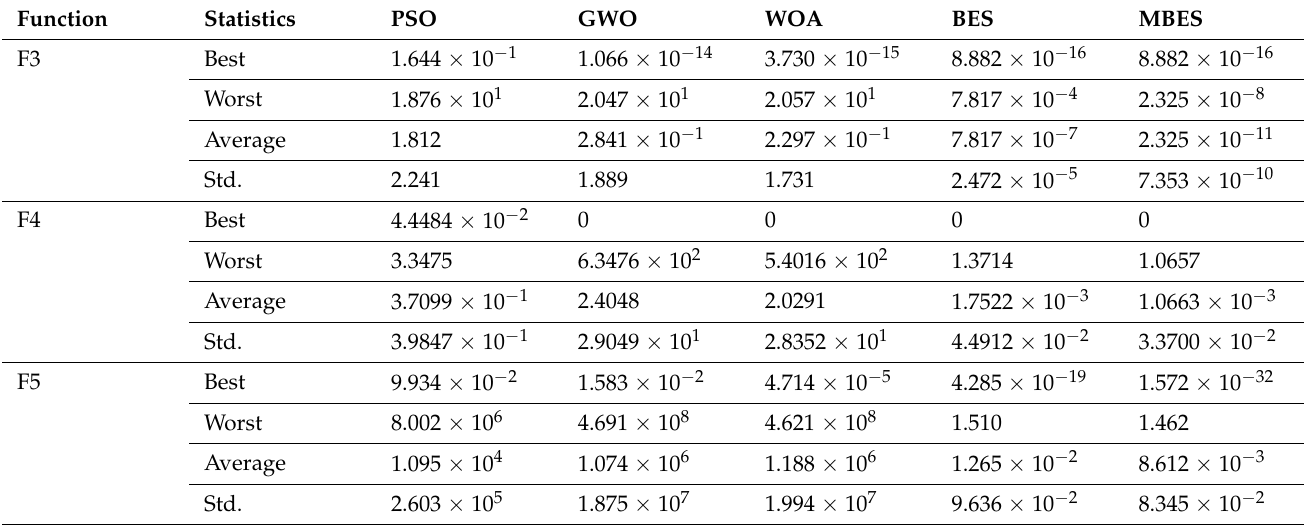
Table 4. Results for multimodal benchmark functions.